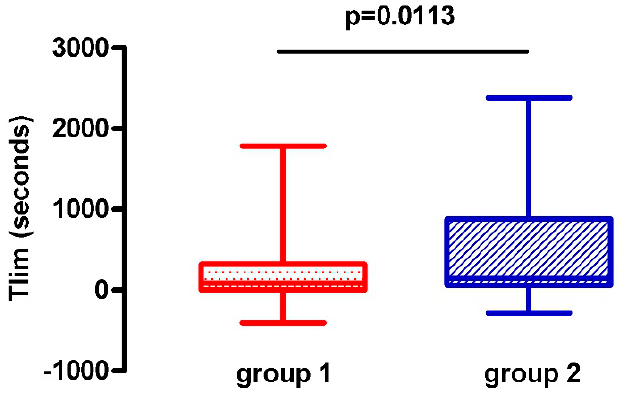
Figure 2. Pre-to-post changes in endurance time of CWR (primary outcome).